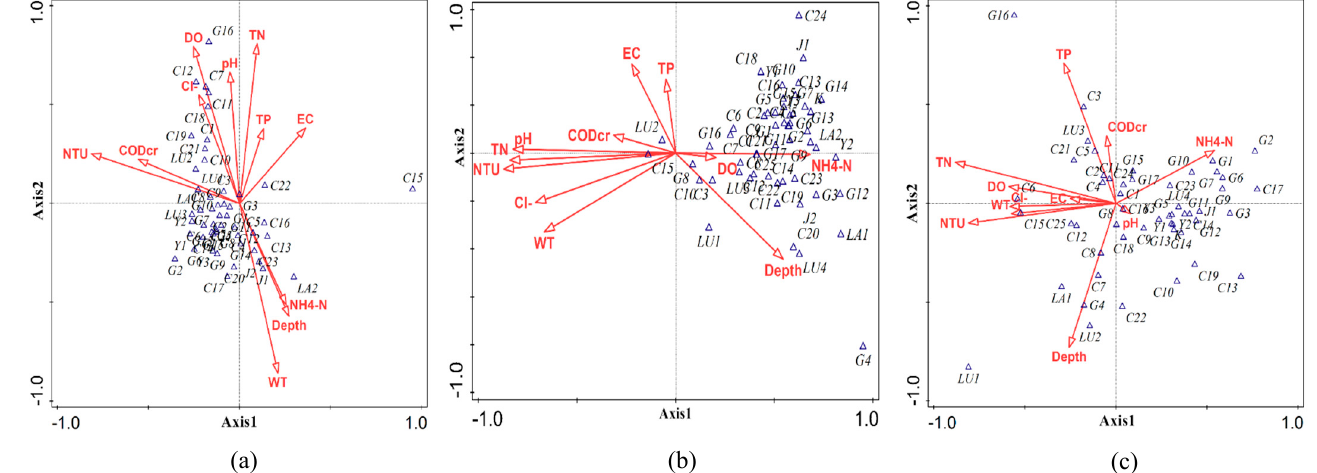
Figure 4. CCA between phytoplankton species and environmental factors in ( a ) spring, ( b ) summer, and ( c ) autumn.